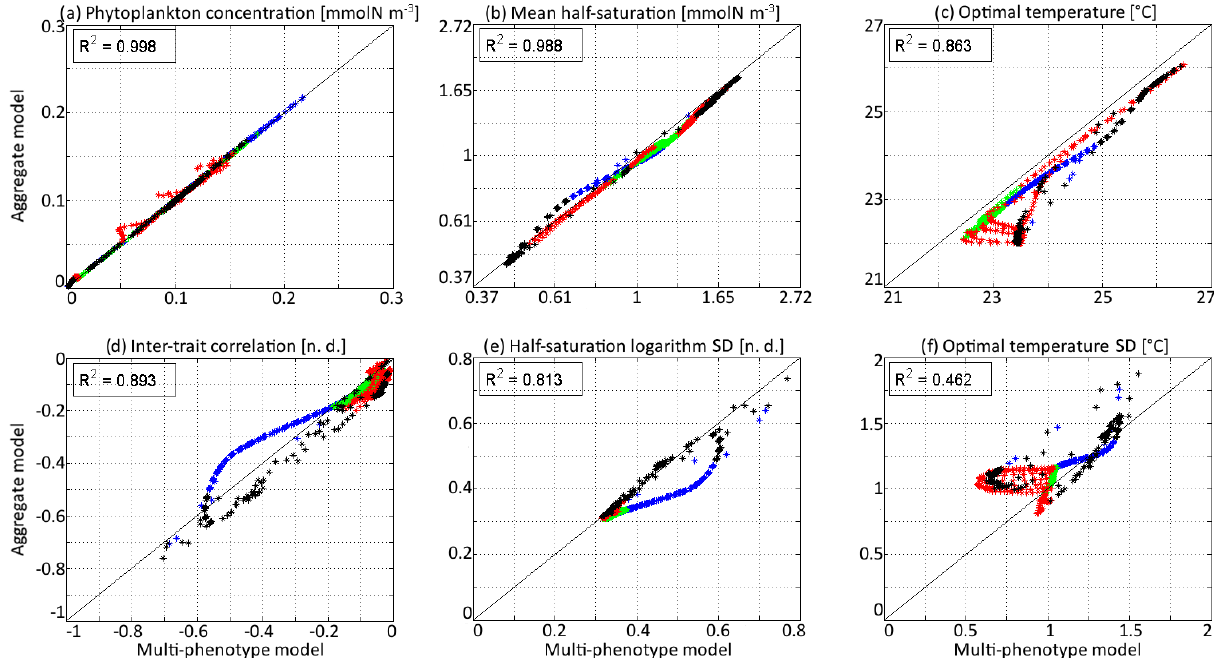
Figure 6. Comparison at all depths and times of the aggregate and multi-phenotype model state variables for ν x = 0 . 001 and ν y = 0 . 01 ◦ C 2 : (a) total phytoplankton concentration, (b) (geometric) mean half-saturation, (c) mean optimal temperature, (d) inter-trait correlation, (e) half- saturation logarithm standard deviation, and (f) optimal temperature standard deviation. Blue is winter, green is spring, red is summer, and black is